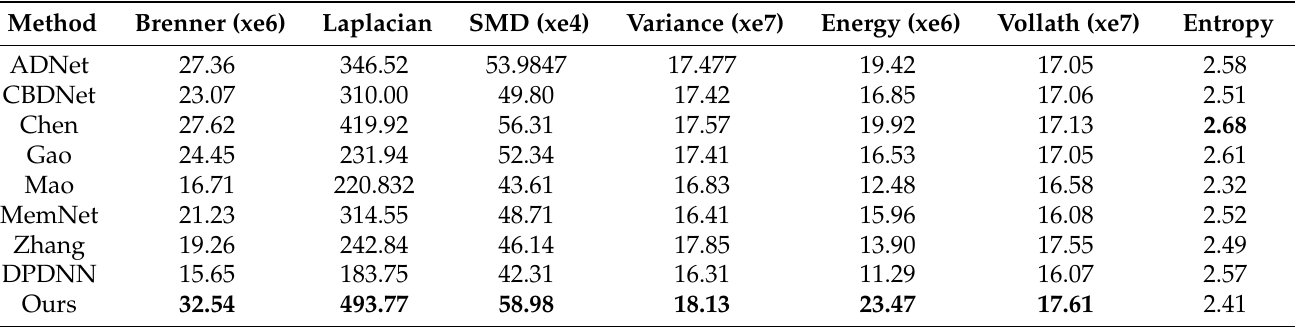
Table 6. Results of non-reference evaluation metrics on real test data (The best results are shown in bold